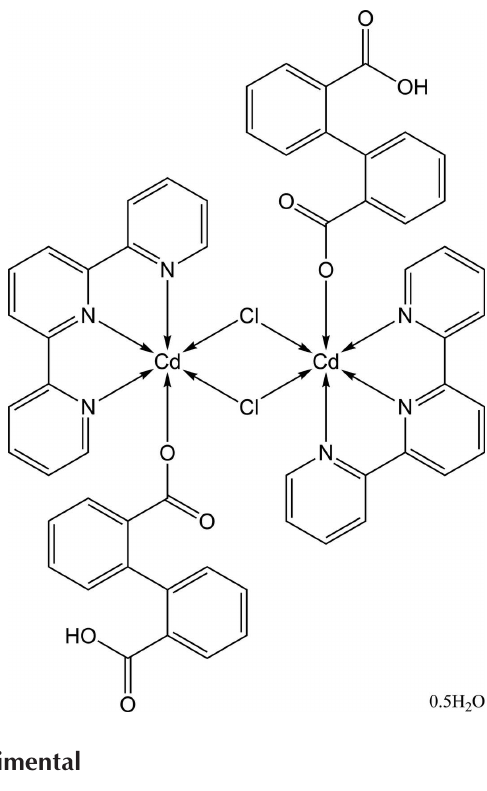
Bruker APEXII CCD area-detector diffractometer Absorption correction: multi-scan ( SADABS ; Sheldrick, 1996)